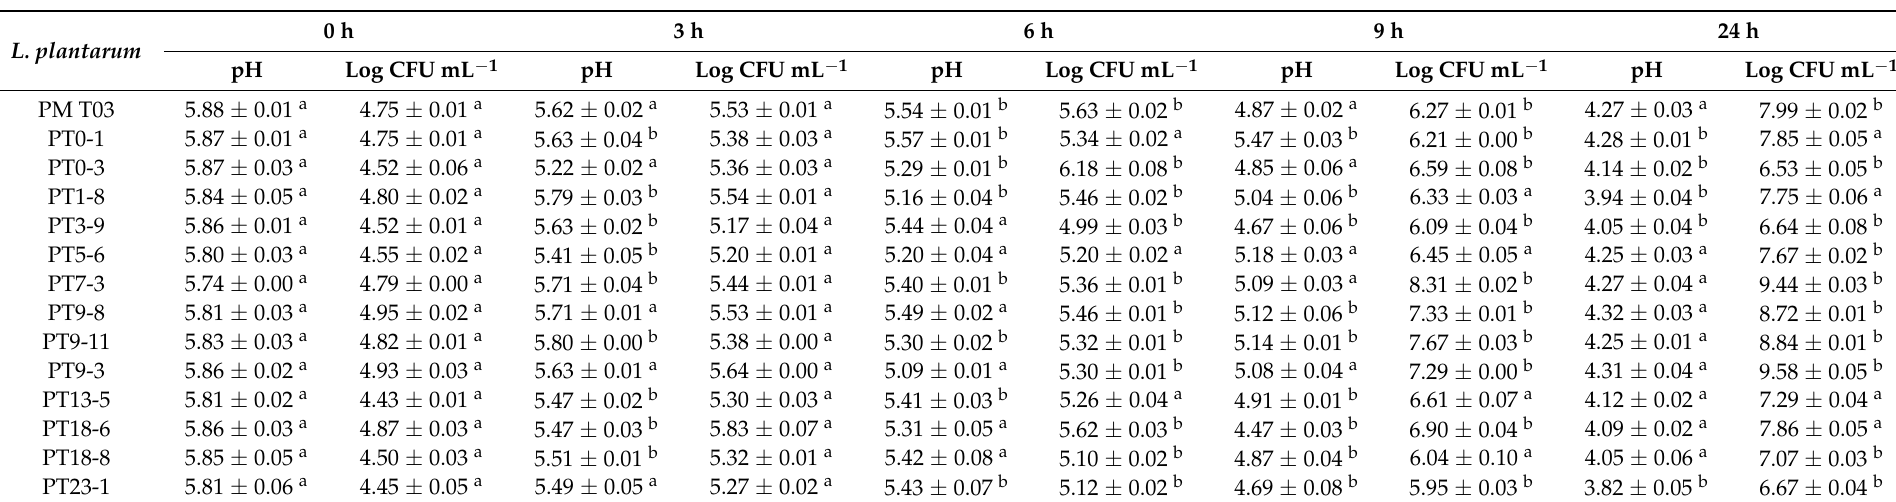
Table 2. Acidifying ability (pH) and growth ability (log CFU mL − 1 ) of 14 L. plantarum strains at different time (0, 3, 6, 9, 24 h) in SB